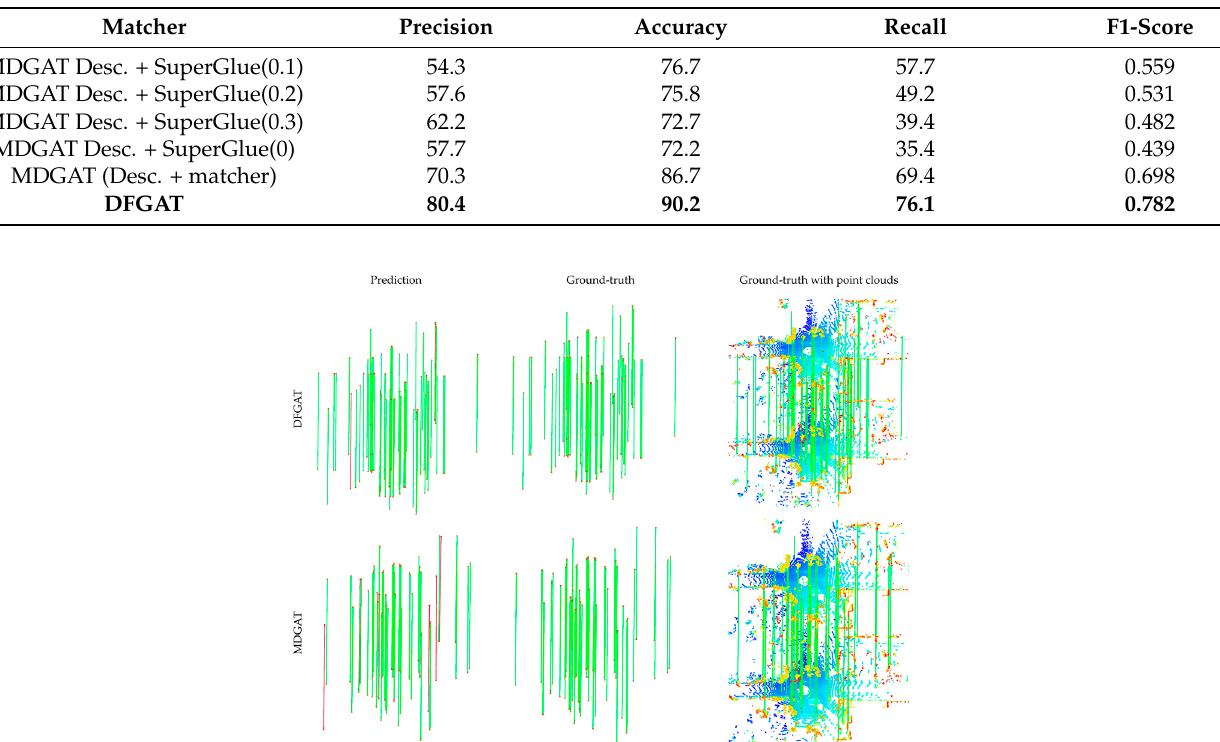
Table 1. Matching performance.